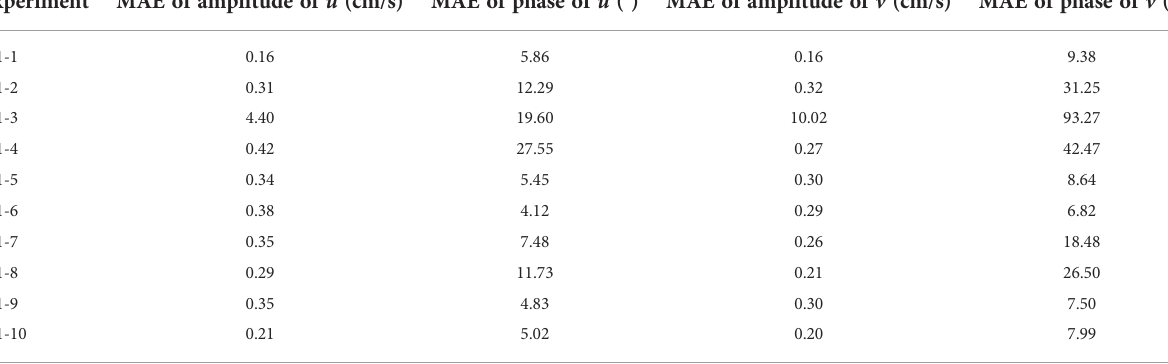
TABLE 3 MAEs of reconstructed tidal currents using part of the observations and prescribed tidal currents in each IE at the mooring MP2. Experiment